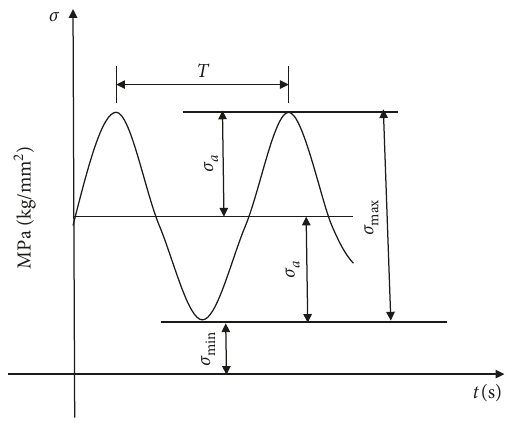
Figure 4: Asymmetric stress period ( σ